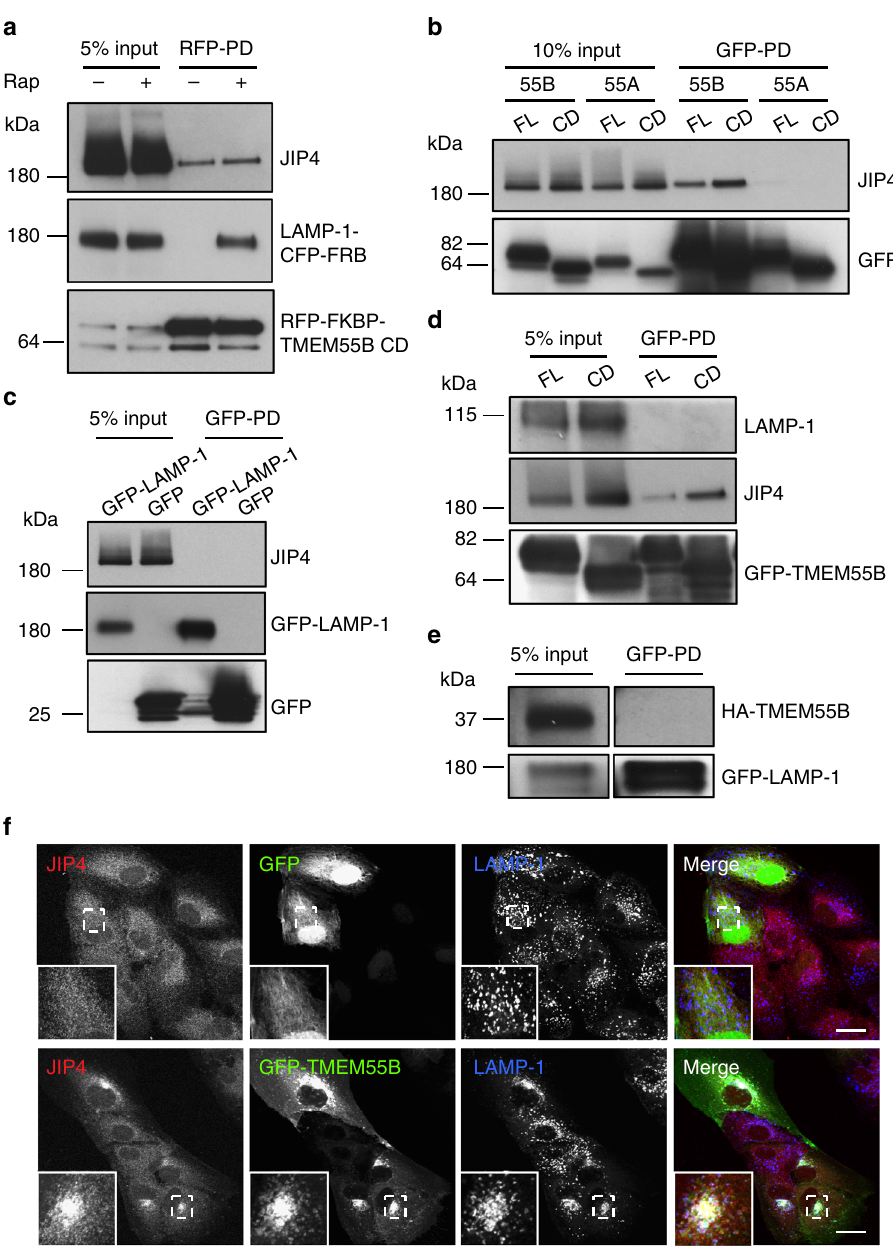
Fig. 4 TMEM55B interacts with Dynein adapter JIP4. a Immunoblot of RFP pull-down from lysates of ARPE-19 cells co-transfected with LAMP-1-CFP-FRB and RFP-FKBP-TMEM55B CD and treated with 200 nM Rapamycin (Rap) (+) or vehicle ( − ) for 2 h. b Immunoblot of GFP pull-down from lysates of ARPE-19 cells transfected with GFP-TMEM55B FL (full length), GFP-TMEM55B CD (cytosolic domain), GFP-TMEM55A FL, or GFP-TMEM55A CD. c Immunoblot of GFP pull-down from lysates of ARPE-19 cells transfected with GFP-LAMP-1 or GFP. d Immunoblot of GFP pull-down from lysates of ARPE-19 cells transfected with GFP-TMEM55B FL or GFP-TMEM55B CD. e Immunoblot of GFP pull-down from lysates of ARPE-19 cells co-transfected with GFP-LAMP-1 and 3xHA-TMEM55B. f ARPE-19 cells were infected with adenovirus expressing GFP (top) or GFP-TMEM55B (bottom) for 24 h. Cells were fi xed, permeabilized, and immunostained with antibodies against JIP4 and LAMP-1. Insets represent a 2.8-fold magni fi cation of the indicated areas. Scale bars, 20 μ